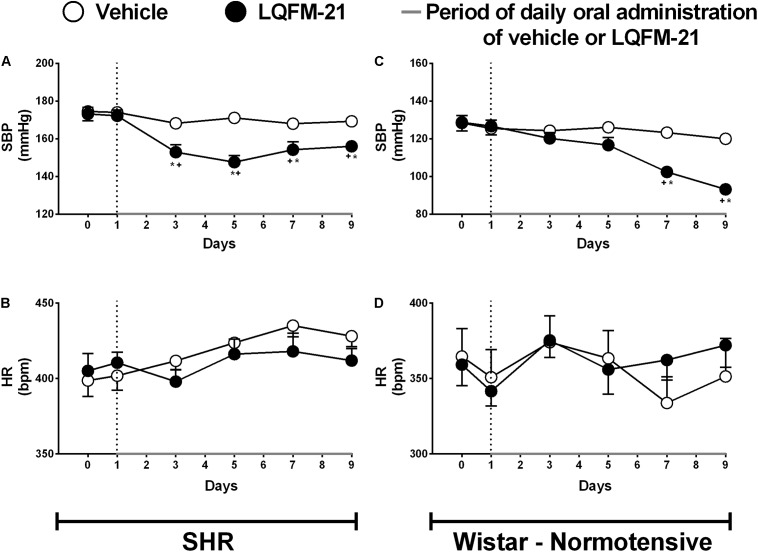
Systolic blood pressure (SBP) in SHR (A) and NTR (C) unanesthetized animals. Heart rate (HR) in SHR (B) and NTR (D) unanesthetized animals. Days 0–1 shown values baseline (SBP) while days 1–9 show measurements (every 48 h) SBP values following daily oral administration of the vehicle or LQFM-21 (15 mg⋅kg-1). Data are expressed as mean ± SEM (n = 10). ∗Values significantly different from baseline; +compared to vehicle; p < 0.05.